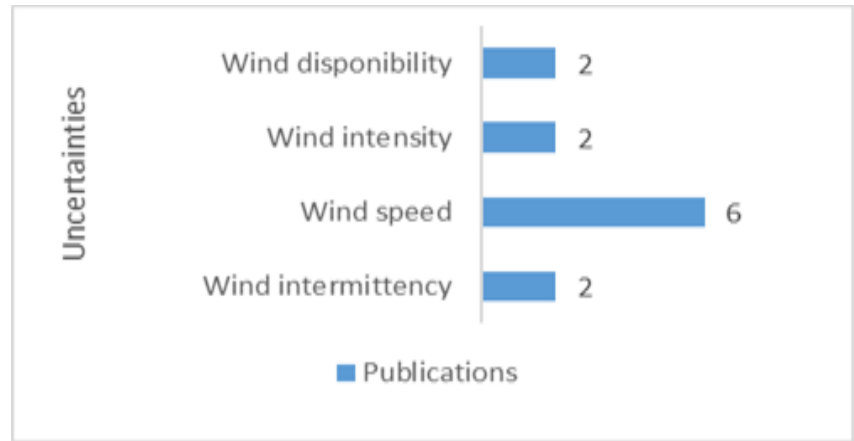
Figure 10. Wind conditions.